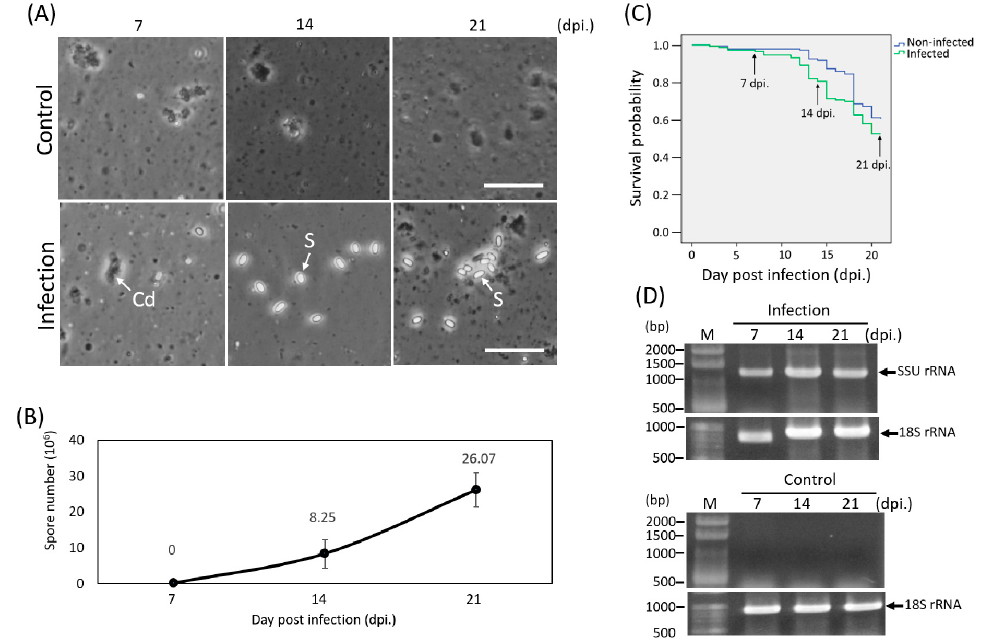
Figure 1. Observations and molecular detection of microsporidia infection at 7, 14, and 21 days post infection (dpi). ( A ) Light microscope observations; at 14 and 21 dpi, the mature spores (S) were formed. Cd = Cell debris; Scale bar = 25 µ m; ( B ) spore number was counted at each time point; ( C ) Kaplan–Meier survival curve; ( D ) molecular detection of microsporidia infection; SSU rRNA = small subunit ribosomal RNA; 18S ribosomal DNA (rDNA) = DNA internal control. Control = non-infected honey infection = infected honey bee.